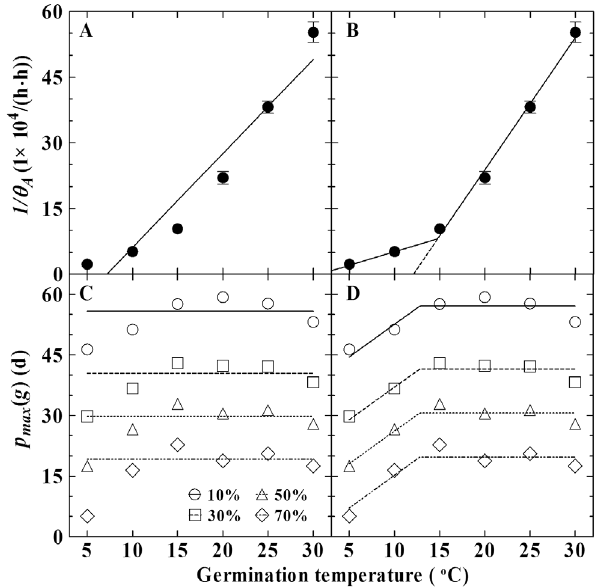
Figure 3. Correlation of 1/ h A and p max ( g ) with germination temperature. 1/ h A and reprehensive p max ( g )s for 10, 30, 50 and 70% estimated from the MLT model were plotted against temperature to show trend of change in these two parameters. 1/ h A was related to all the germination temperatures with a linear line (A, R 2 =0.926) or related separately to temperatures at 5–10 u C and 15–30 u C with two different linear lines (B, R 2 =0.996). p max ( g ) was assumed to be constant across all the germination temperatures (A) or to be constant at 15–30 u C and declined linearly with temperature decreased at 5–10 u C (B, R 2 =0.914).